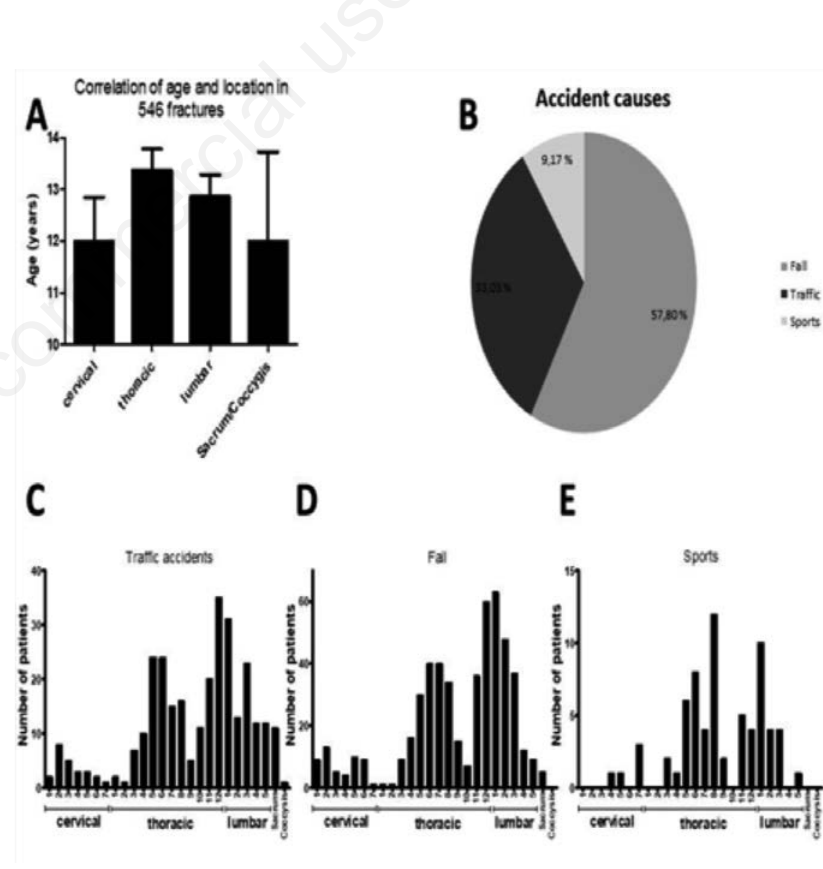
Figure 2. Correlation of age and location in 546 fractures (A). Younger patients had a ten- dency to injure the cervical spine. Accident causes (B). Falls were the most common rea- son for injury followed by traffic and sporting accidents. Localization of 297 fractures in traffic accidents (C) with a peak in the thoracolumbar area, after fall with 514 fractures and a peak in the thoracolumbar area as well (D) and during sports activities with 68 fractures (E) and a thoracic